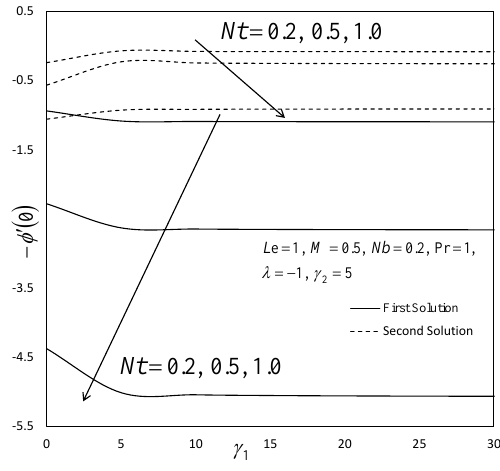
Figure 17. Variations of − φ (cid:48) ( 0 ) towards γ 1 for selected values of Nt